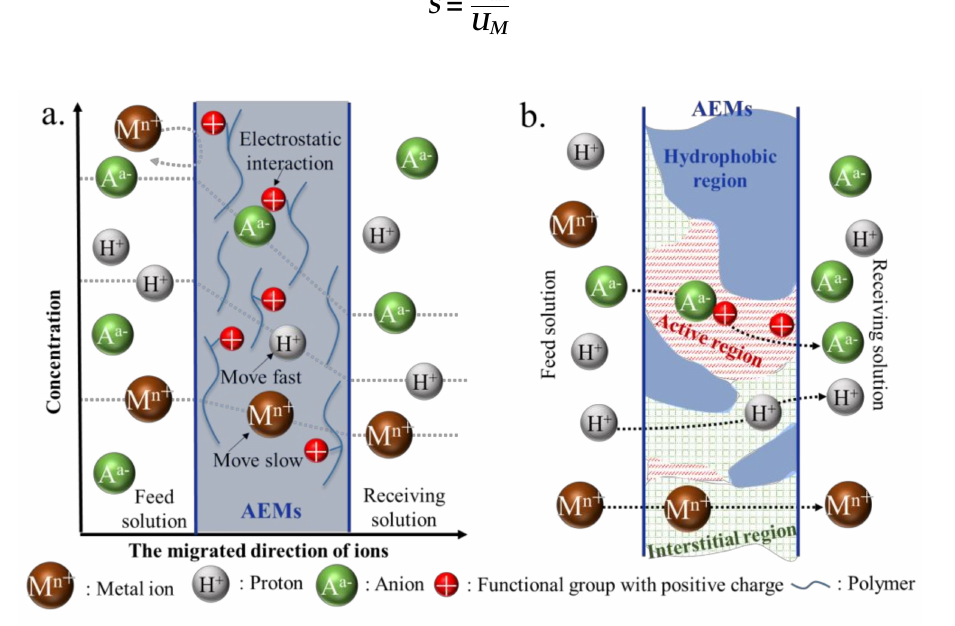
Figure 3. The solution-di ff usion model ( a ) and the three-phase membrane model ( b